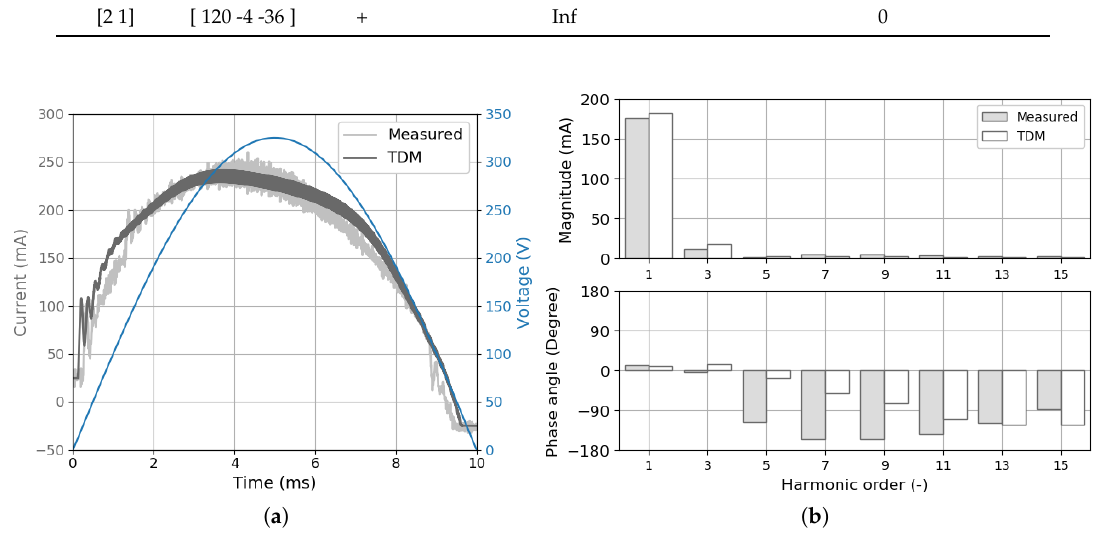
Figure A8. Comparison of measured data and the Type D LED lamp time-domain model (TDM) output at rated ideal sinusoidal condition: ( a ) Time domain. ( b ) Spectral